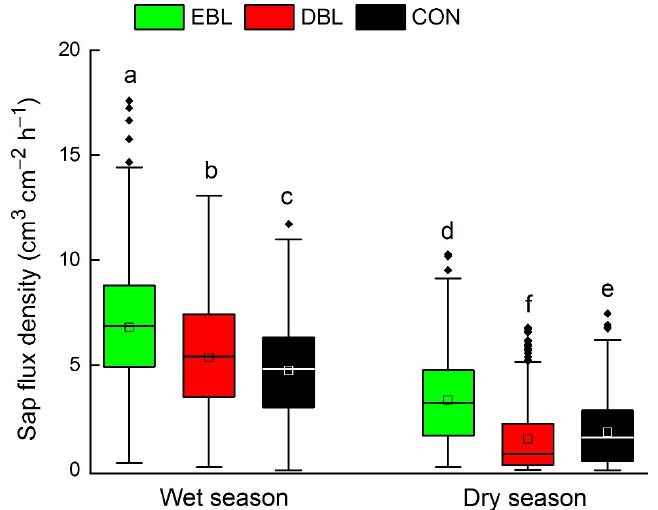
Figure 2. Daily average of sap flux densities in evergreen broad-leaved trees (EBL), deciduous broad-leaved trees (DBL), and conifers (CON) between May 2016 and March 2019. Missing data were due to instrument or power failure.